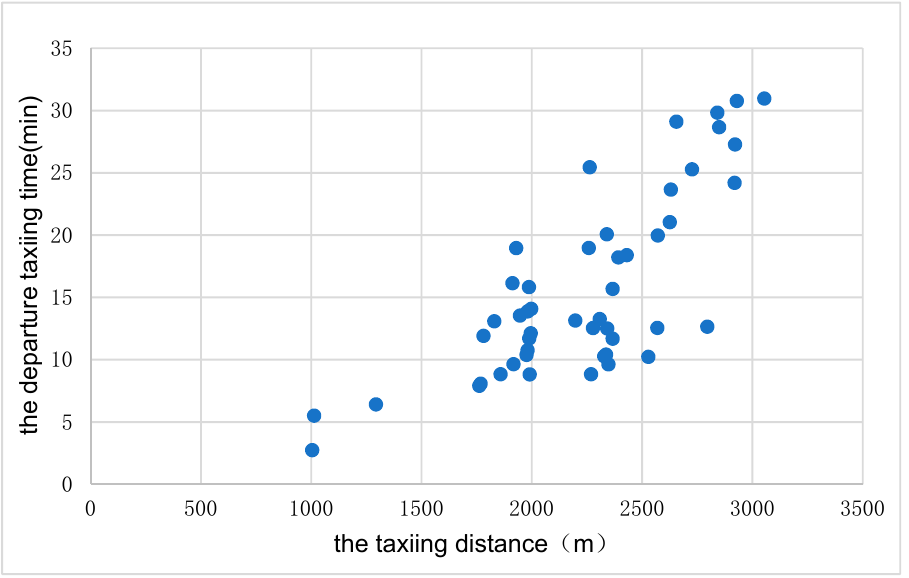
Figure 6. The scatter diagram of the relationship between the flight taxi time and the taxi distance.